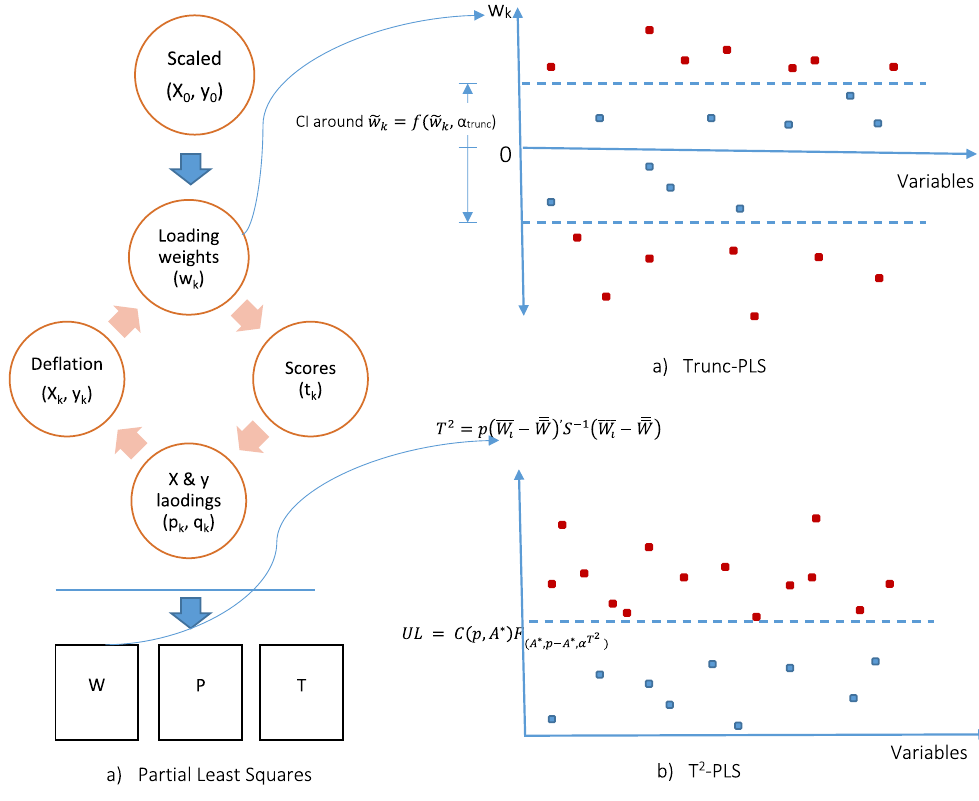
Figure 1. The computational structure of Trunc-PLS and T